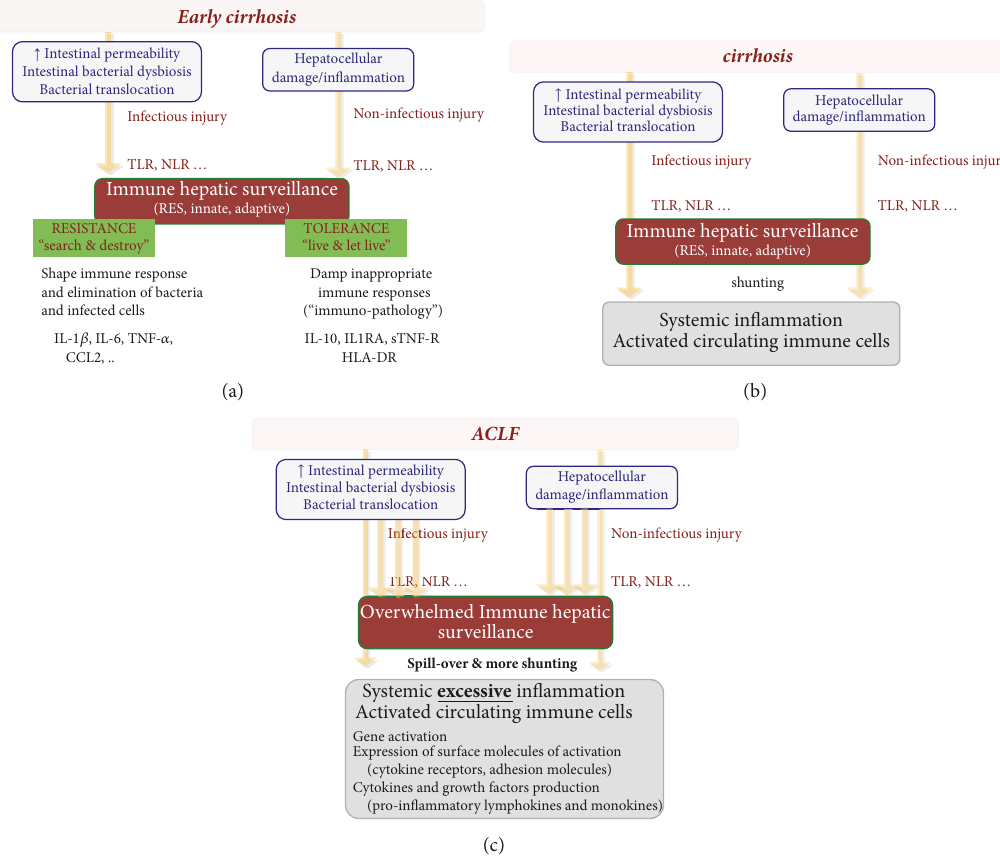
Figure 2: The dynamic course of immune function in evolving cirrhosis: cirrhosis-associated immune: (a) early cirrhosis sets the stage for ACLF; (b) evolving cirrhosis primes the systemic immune system and finally culminates in ACLF (c).